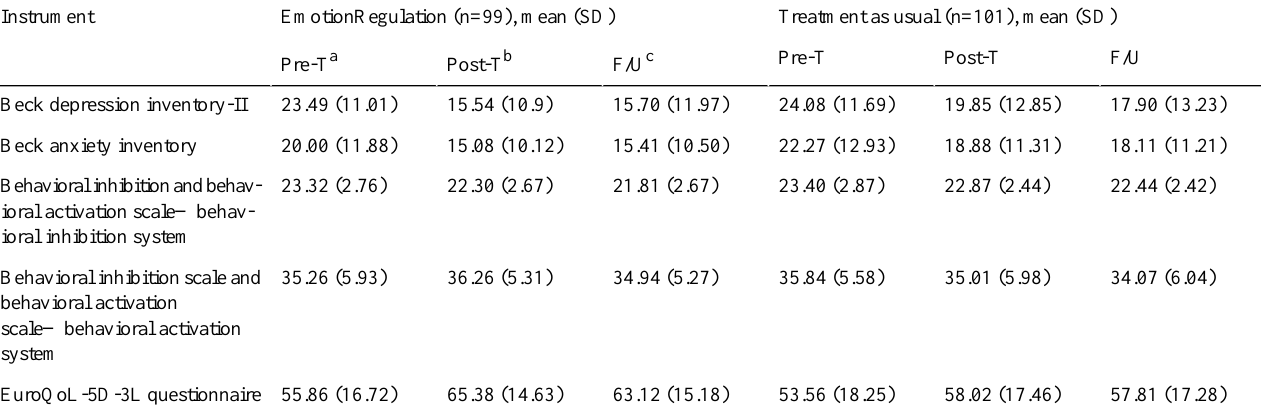
Table 3. Descriptive statistics for EmotionRegulation and treatment as usual at pretreatment, posttreatment, and 3-month follow-up.